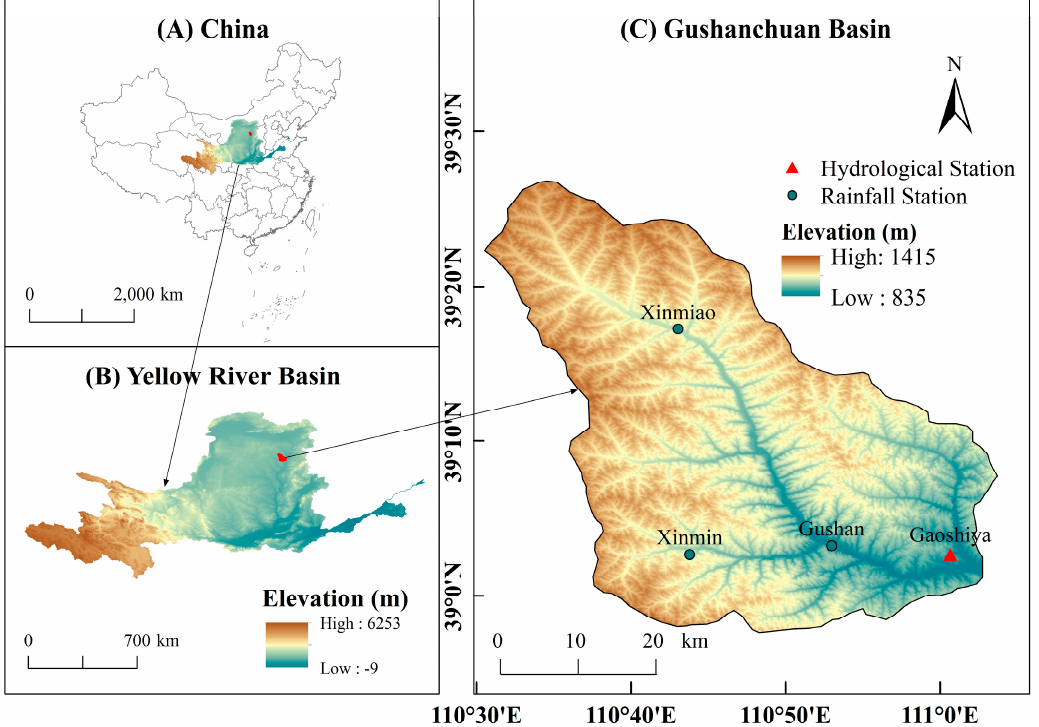
Figure 1. Map of the Gushanchuan basin. ( A ) Inset map showing the location of the Yellow River Basin in China; ( B ) Location of the Gushanchuan watershed along the Yellow River basin; ( C ) The control catchment of Gushanchuan basin and distribution of rainfall-runoff gauge stations.